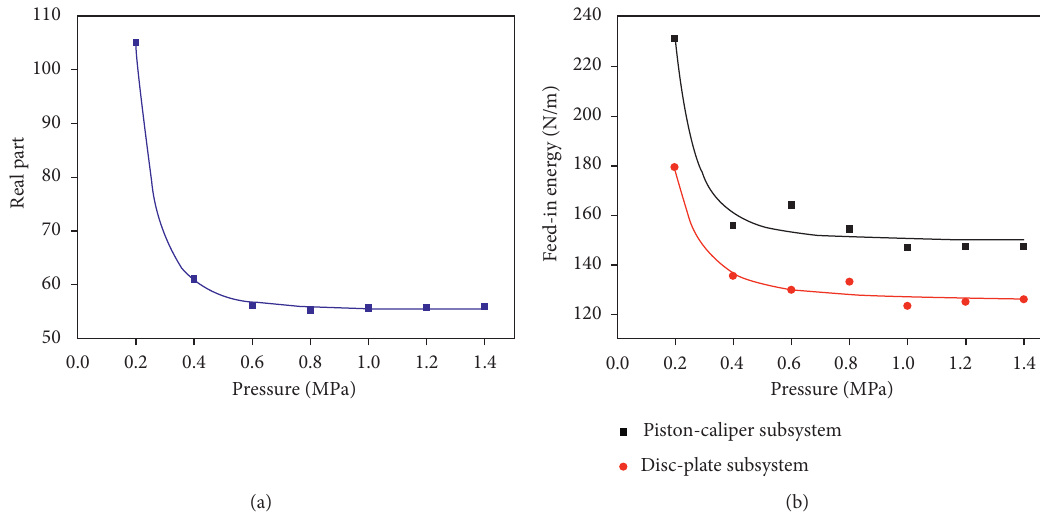
Figure 8: Relationships between brake oil pressure, real part, and feed-in energy at 4000Hz. (a) Power function relationship between brake oil pressure and the real part. (b) Power function relationship between brake oil pressure and feed-in energy.